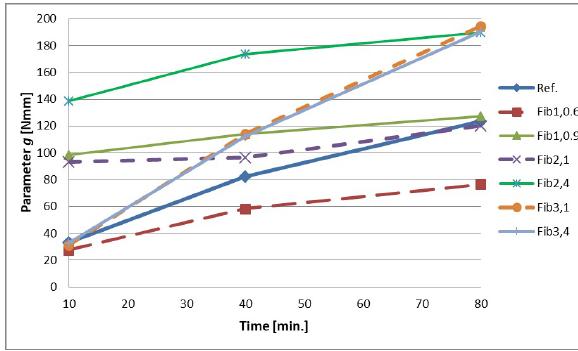
Figure 8: Dependency of the parameter g on fiber type, fiber content and